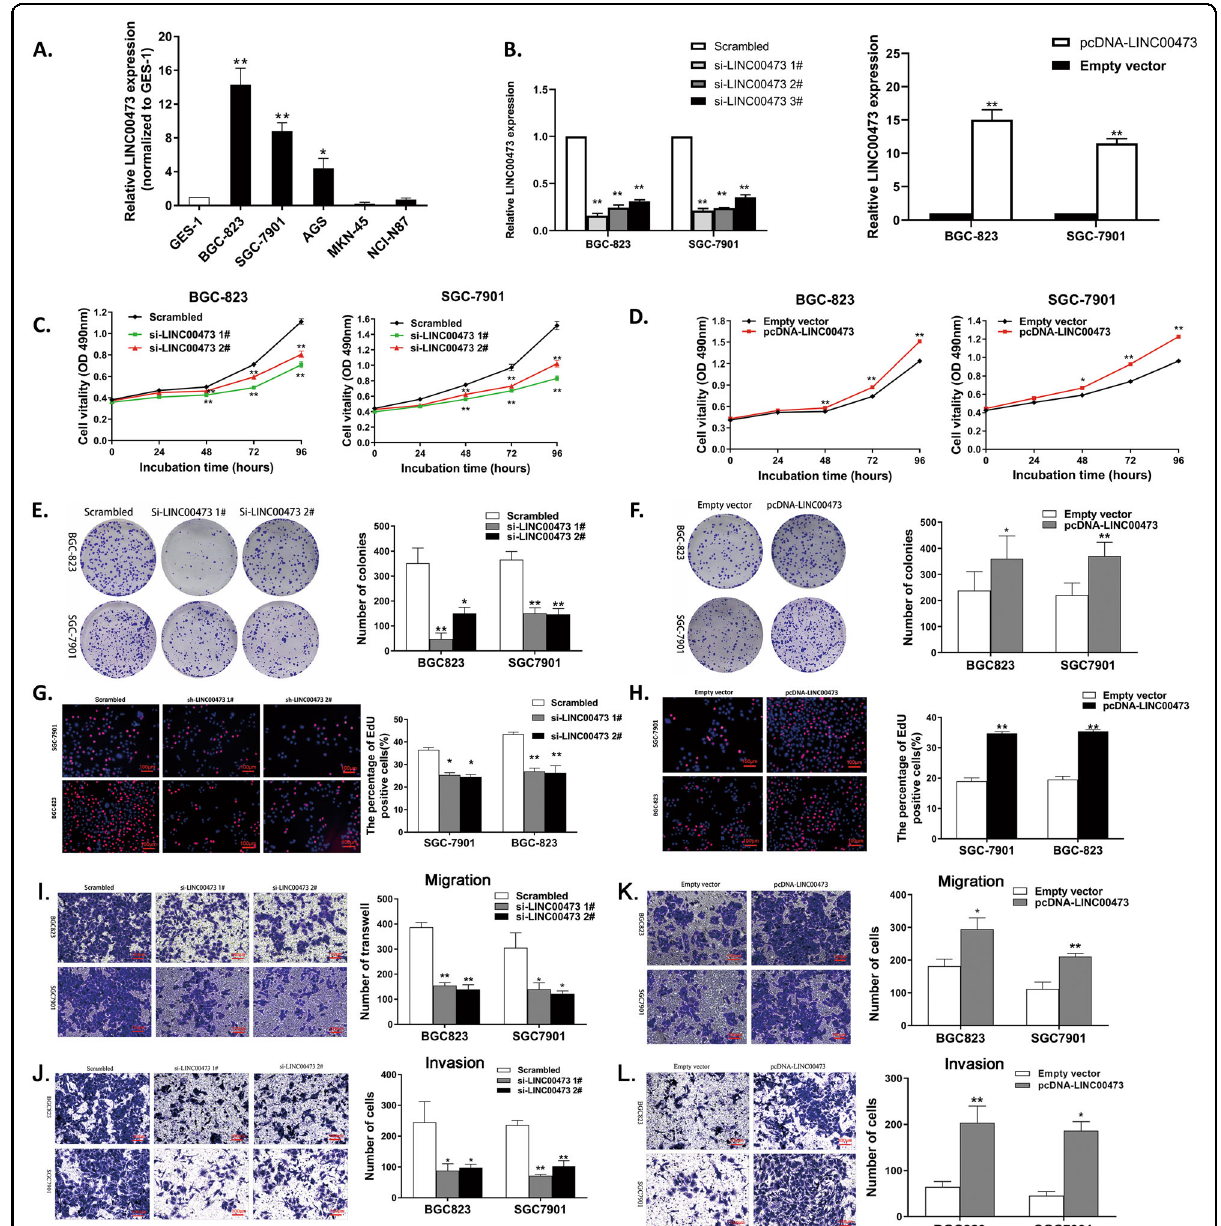
Fig. 2 LINC00473 affects gastric cancer cell proliferation and metastasis. A LINC00473 expression was detected by qRT-PCR in GC cell lines (BGC823, SGC7901, AGS, MKN-45, and NCI-N87) compared with the normal gastric epithelium cell line (GES-1). B Expression of LINC00473 in BGC823 and SGC7901 cells transfected with three siRNAs and pcDNA-LINC00473 were detected by qRT-PCR. C and D CCK-8 assays were performed to determine the viability of BGC823 and SGC7901 cells transfected with si-LINC00473 or pcDNA-LINC00473. E and F The proliferation of si-LINC00473 or pcDNA-LINC00473 transfected BGC823 and SGC7901 cells were veri fi ed by the colony-formation assays. G and H EdU immunostaining assays were used to determine the cell proliferation ability of si-LINC00473 or pcDNA-LINC00473 transfected BGC823 and SGC7901 cells. I and J The migration and invasion abilities of BGC823 and SGC7901 cells transfected with si-LINC00473 or scrambled 24 h were checked by Transwell assays. K and L Transwell assays were used to determine the cell metastasis of pcDNA-LINC00473 transfected BGC823 and SGC7901 cells. Original magni fi cation, ×100. Scale bar: 100 µm.Values are shown as the mean ± SD based on three independent experiments. * P < 0.05, ** P <